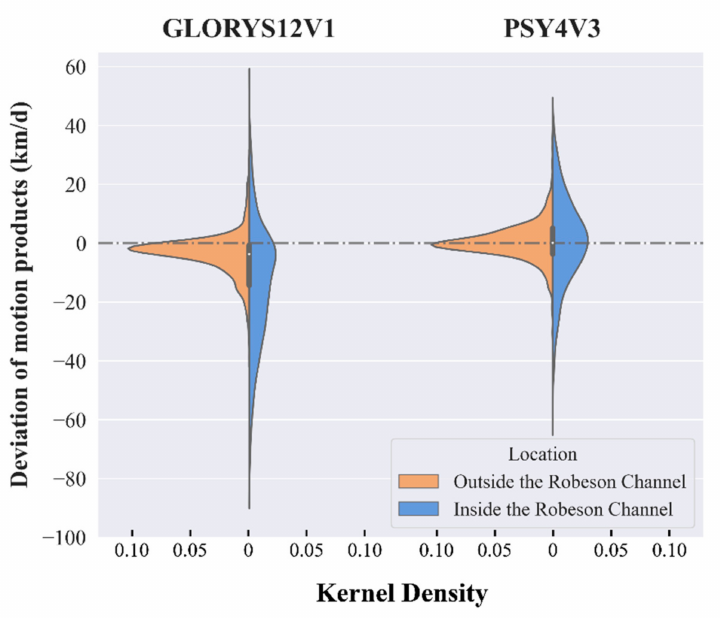
Figure 14. Distributions of the deviation of the sea ice motion products for the sea ice floes inside and outside the Robeson